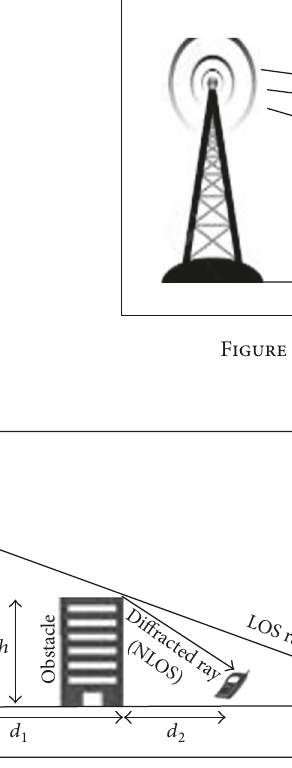
Figure 3: Diffraction of rays when line-of-sight is